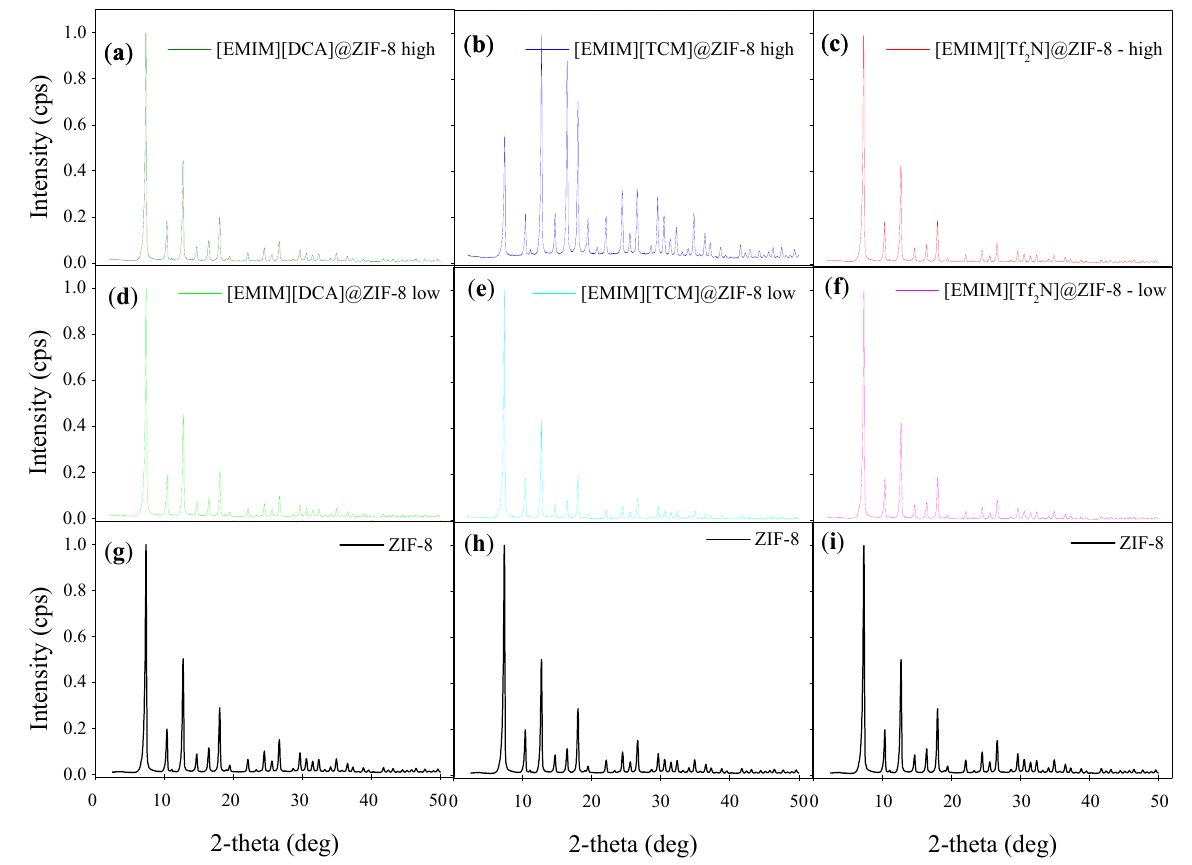
Figure A3. PXRD diffractograms of ZIF-8 compared to IL@ZIF-8 composites: ( a ) [EMIM][DCA]@ZIF-